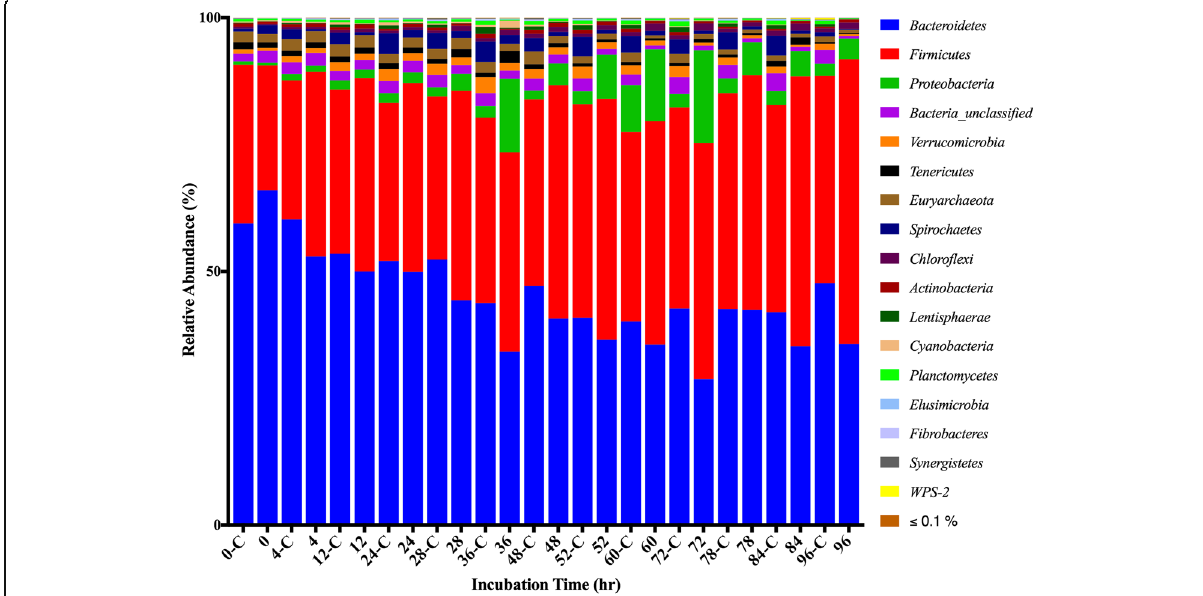
Fig. 5 Relative abundance of phyla during in-vitro fermentation. Fermentations were performed in three in-vitro vessels (n = 3). Incubation times annotated with “ C ” represent control